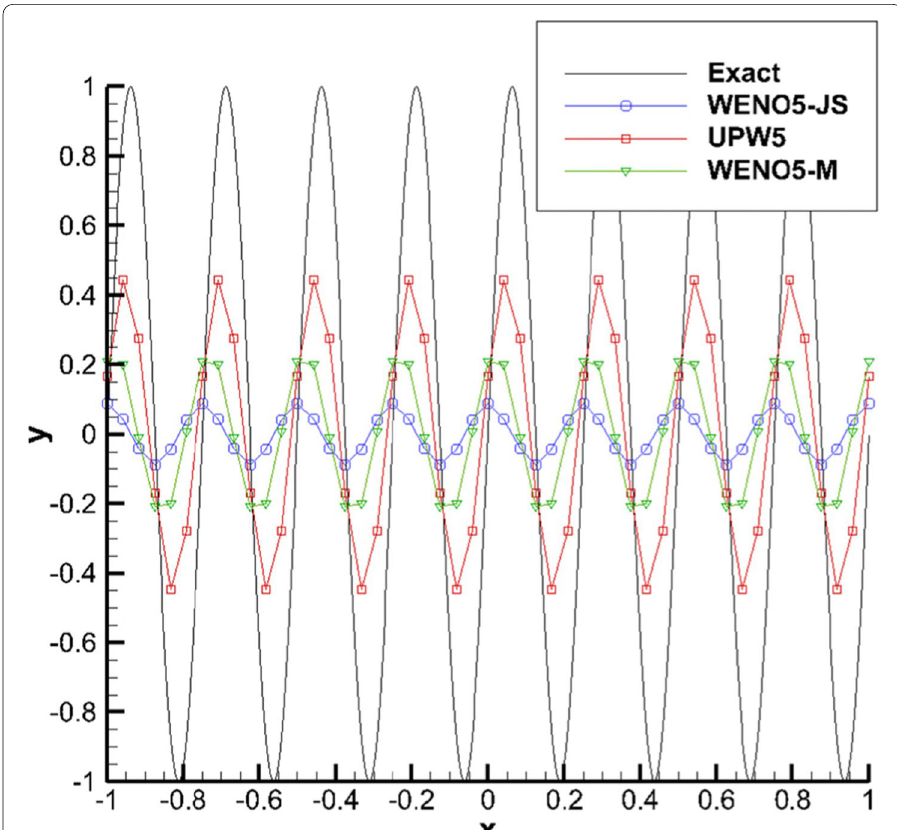
Fig. 7 Results for UPW5, WENO5-JS, and WENO5-M with RK 4 for grid size N x ω Δ t 10 − 3 =